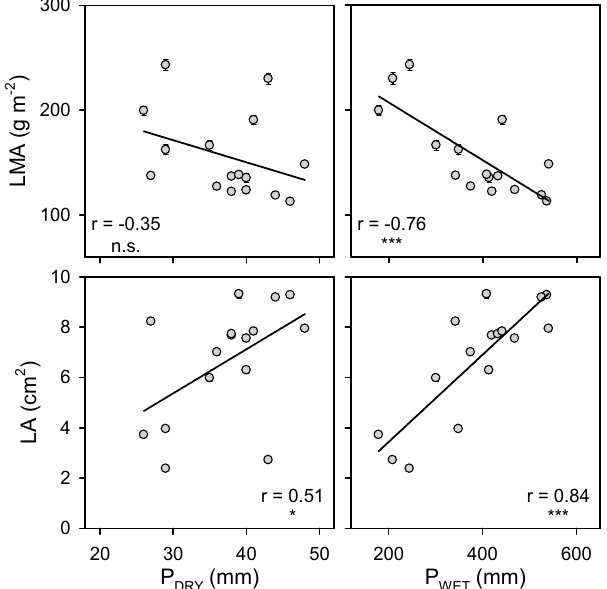
Figure 8. Relationships between leaf mass per area (LMA), leaf area (LA), precipitation of driest quarter (P DRY ) and precipitation of wettest quarter (P WET ) for the 16 Quercus suber populations (* p < 0.05; *** p < 0.001; n.s. means not significant). P DRY is the precipitation of April, May and June while P WET corresponds to the precipitation of October, November and December.